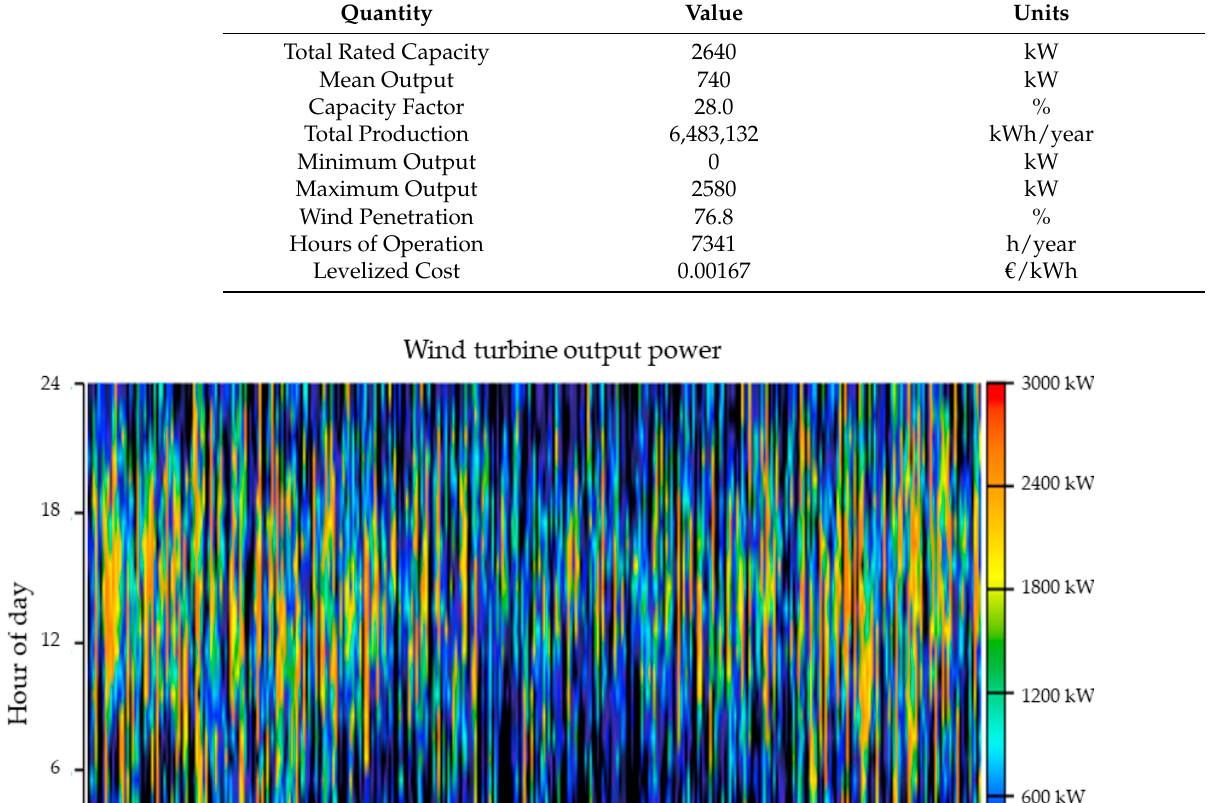
Table 6. Thermal energy demand and